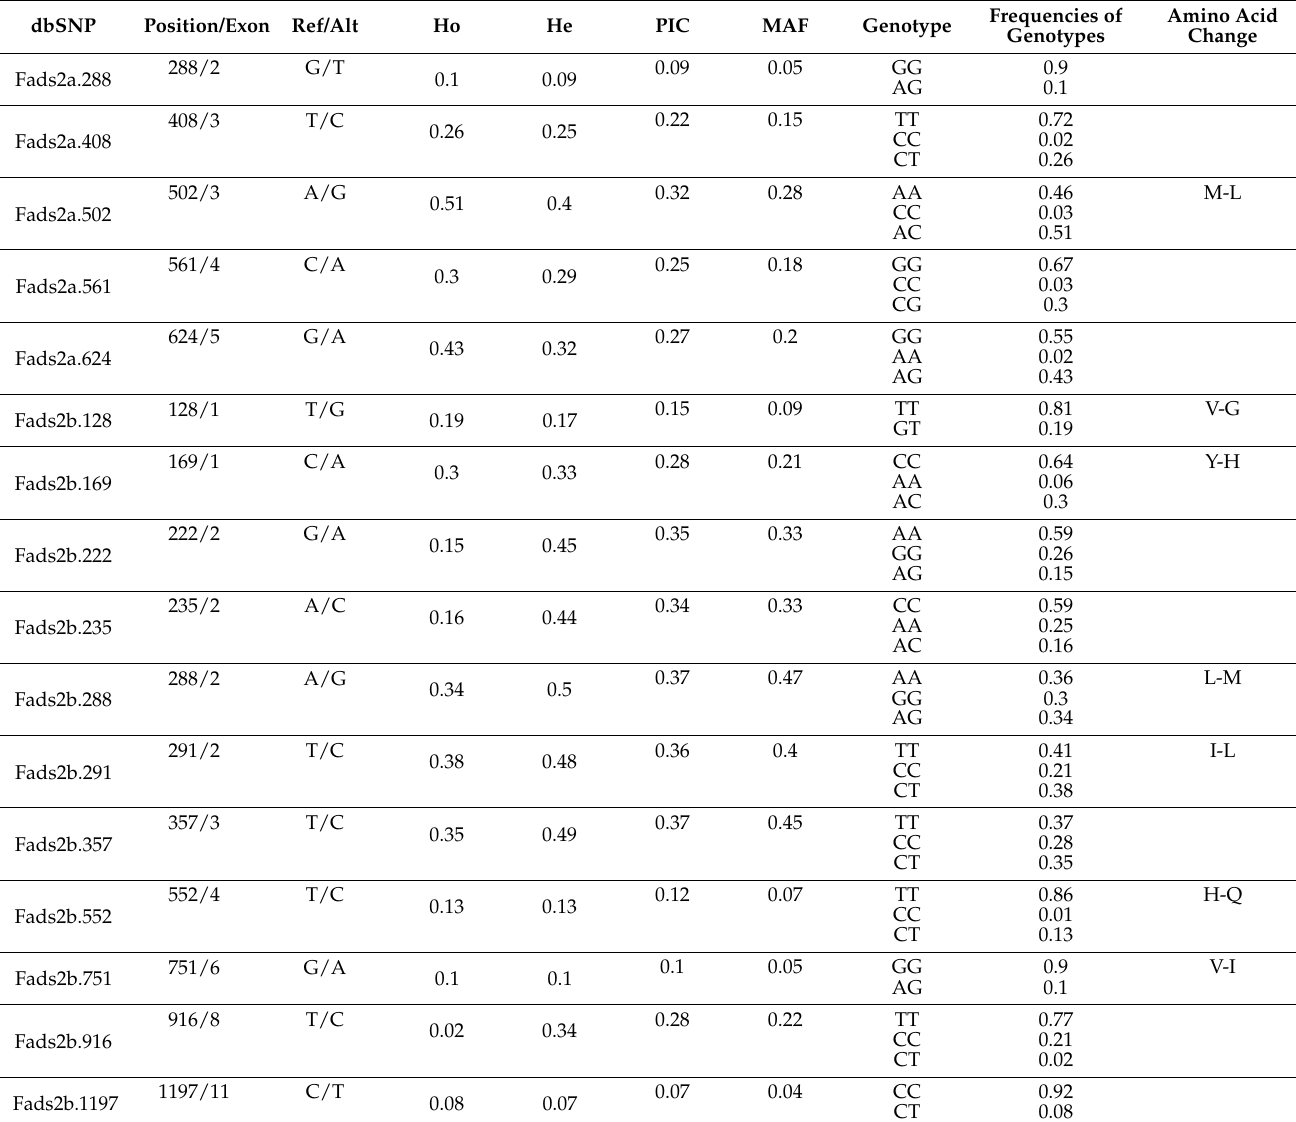
Table 2. Genetic diversities of cSNPs in fads2a and fads2b